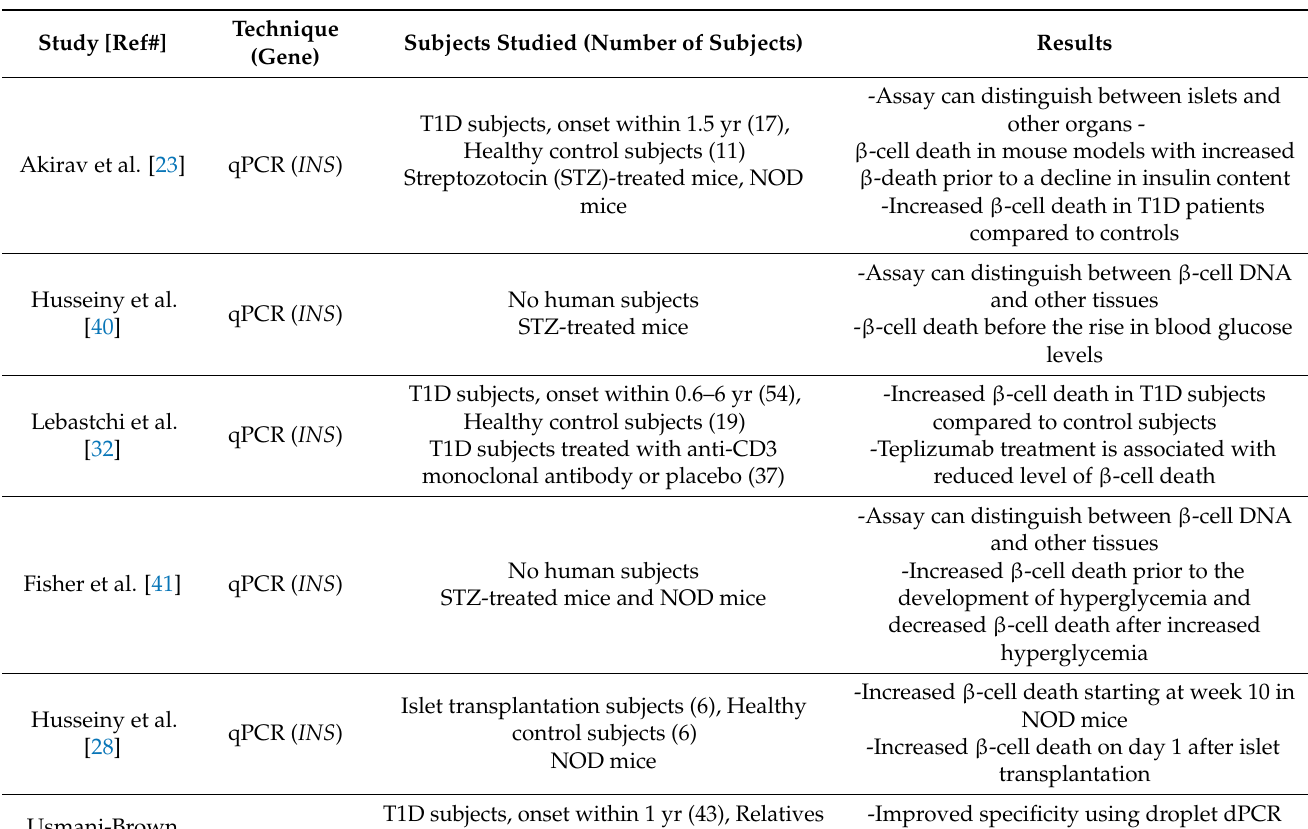
Table 1. Published studies utilizing differentially methylated DNA to interrogate islet β -cell